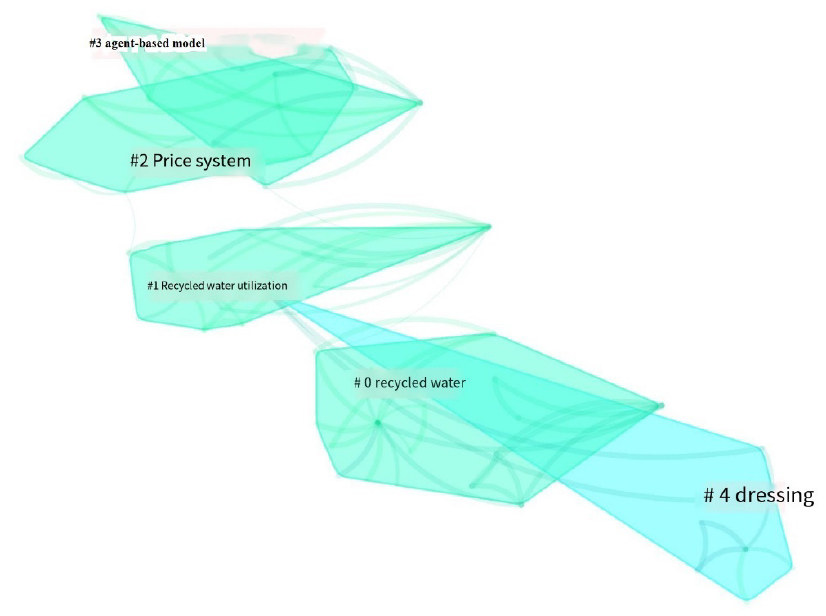
Figure 10. CNKI keyword clustering.